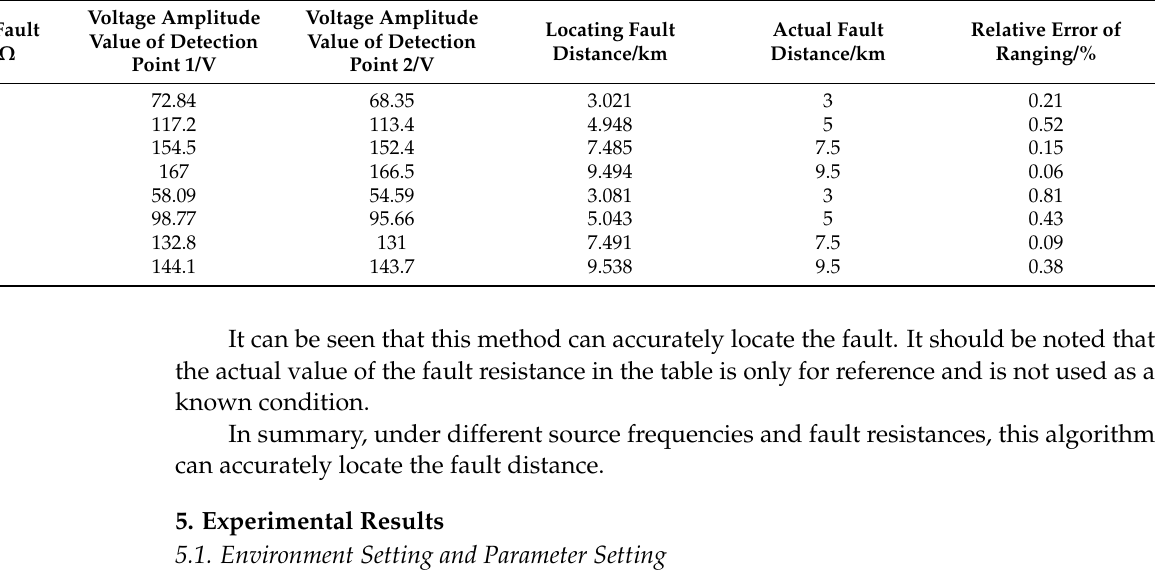
Table 4. Analysis of fault location